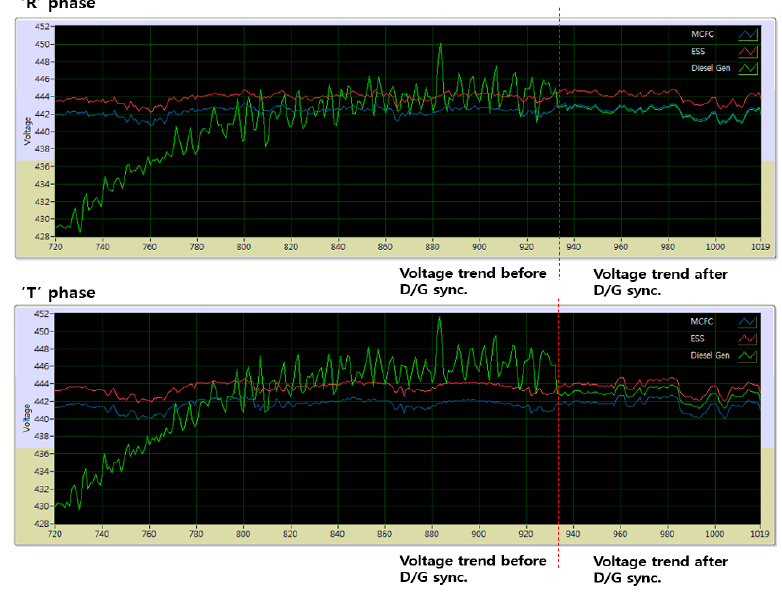
Figure 20. Voltage change when synchronizing diesel generators.